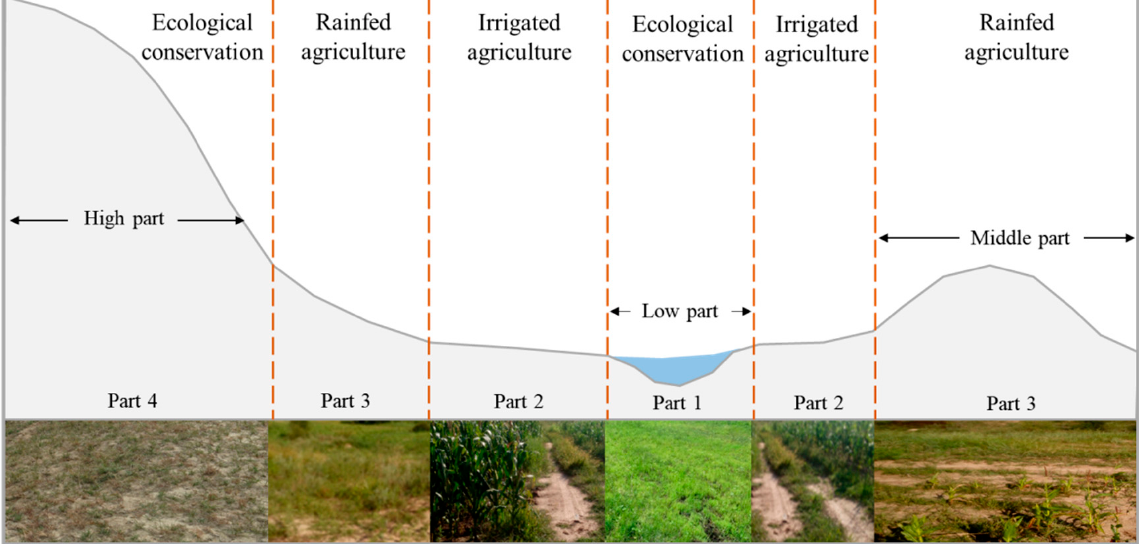
Figure 5. Spatial distribution patterns of irrigated and rainfed agricultural land in the semi-arid sandy region.